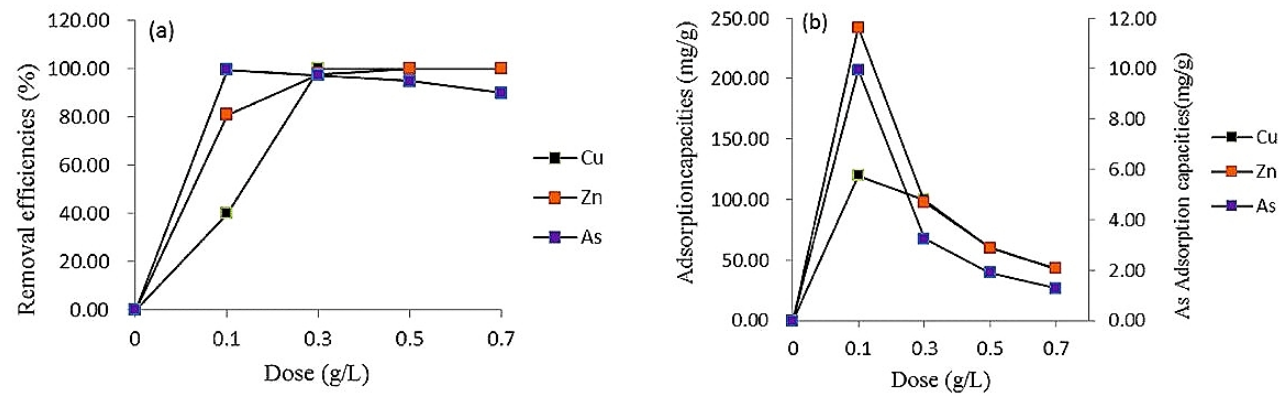
Figure 17. The effect of PMSB dosage on the removal efficiency ( a ) and adsorption capacity ( b ) of Cu, Zn, and As [135]. Reprinted with permission from Zhiyong Xu et al. (2021). Copyright 2021, Elsevier.